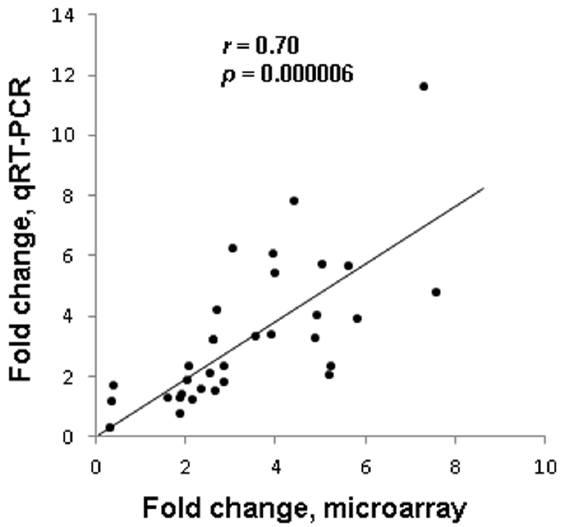
Figure 7. qPCR validation of METH-induced changes identified by microarray analysis. There is a significant correlation between METH-induced changes in the expression of genes identified by microarray analysis and validated by